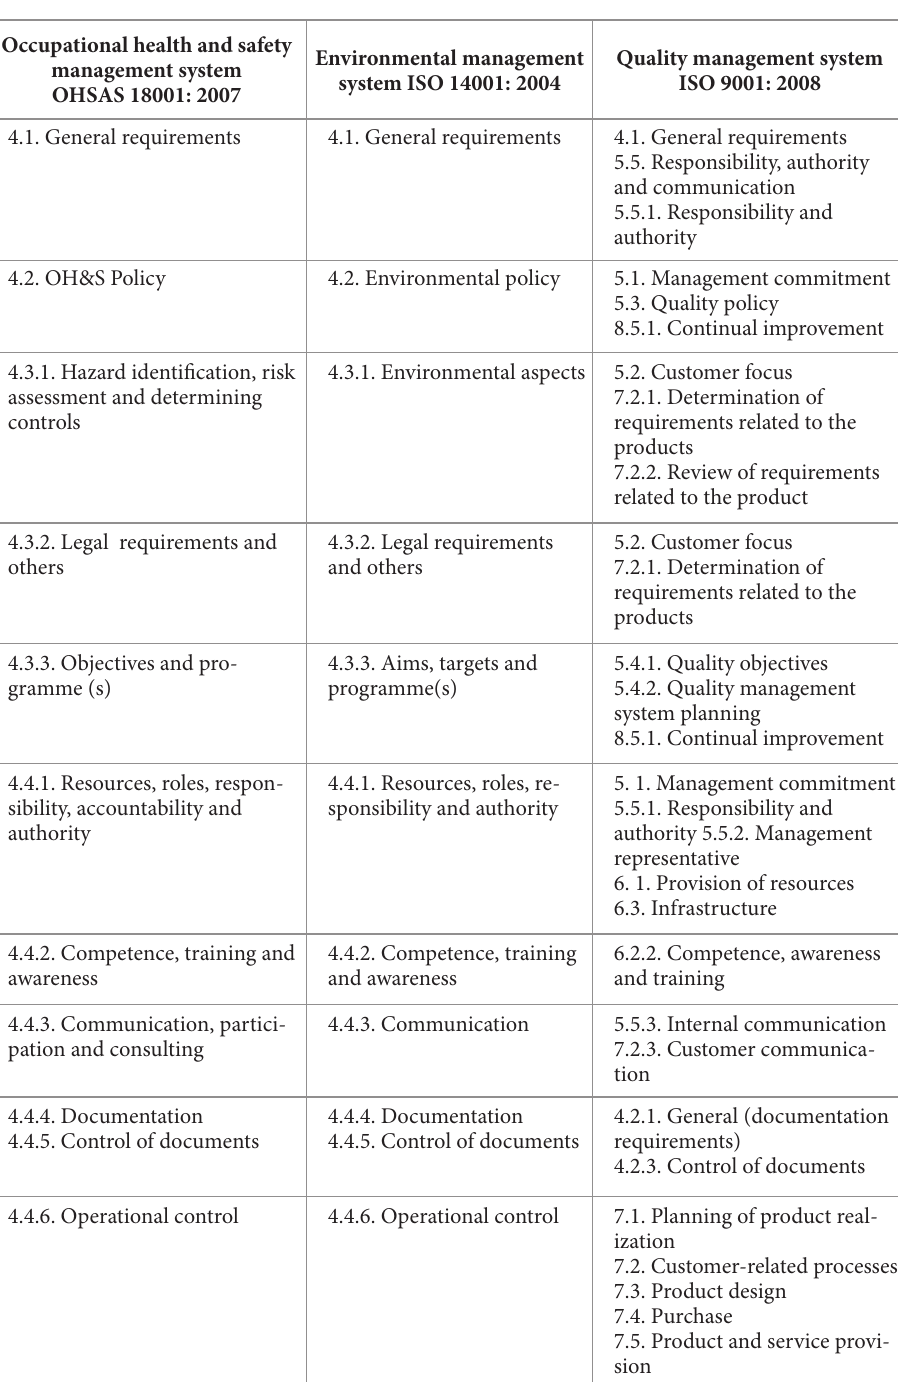
Table 4. The relation between quality, environmental and safety management systems corresponding to international standards Occupational health and safety management